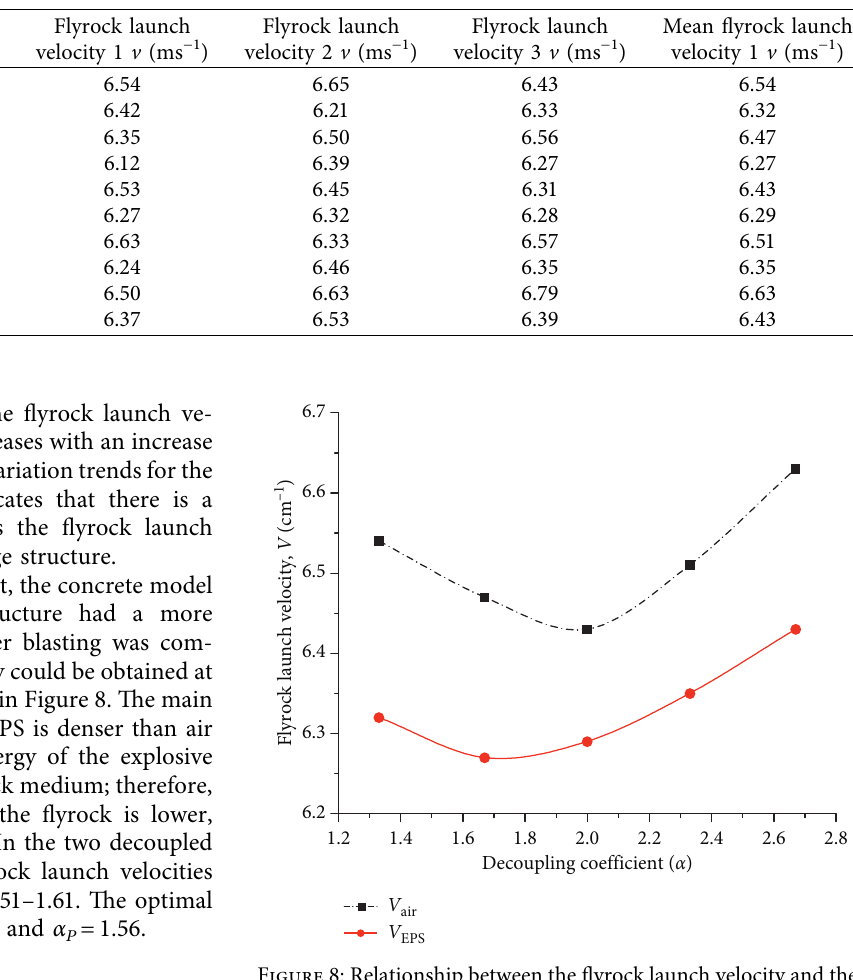
Table 5: Flyrock launch velocities of the model specimens.